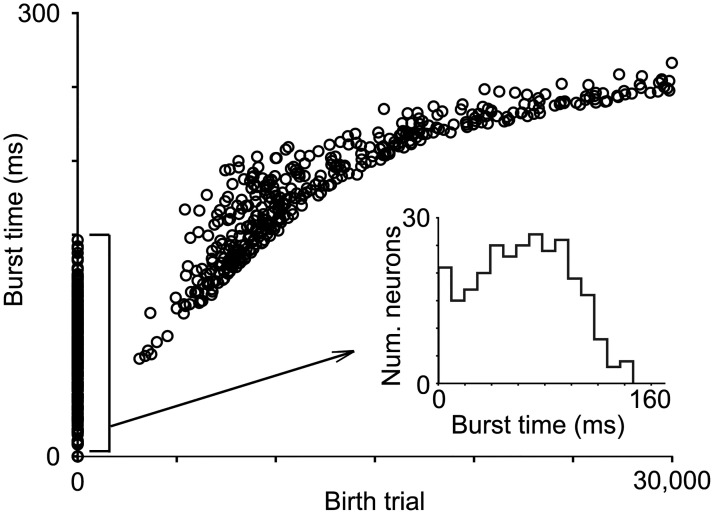
“Birth time” and burst time.The “birth time” is the trial number at which a new immature HVCRA neuron is introduced to replace a non-recruited silent neuron. The birth time is positively correlated to the burst time of the neuron in the network. The points at trial 1 are the neurons that existed at the start of the wiring process. The insert plots the bursting time histogram for this population. The replacements starts at trial 4000 in the model. Soon after the replacement starts, the new immature neurons are more likely to get recruited than the resident neurons that have been maturing since their birth times. This can be seen in the insert: Soon after the replacements have started, the number of neurons that existed at trial 1 and recruited to the network trails off.